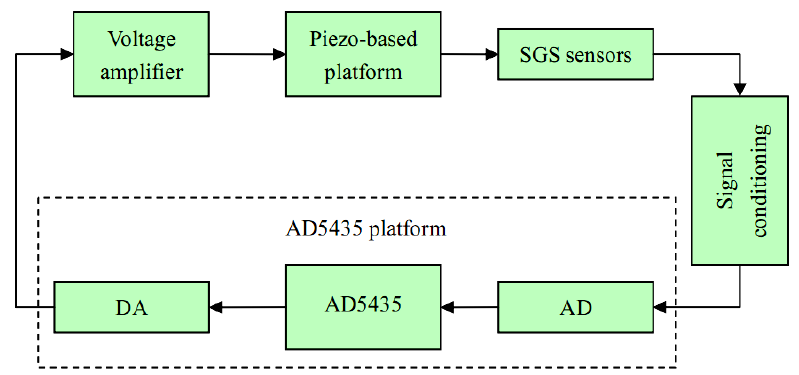
Figure 1. Experimental components for precision angle motion.